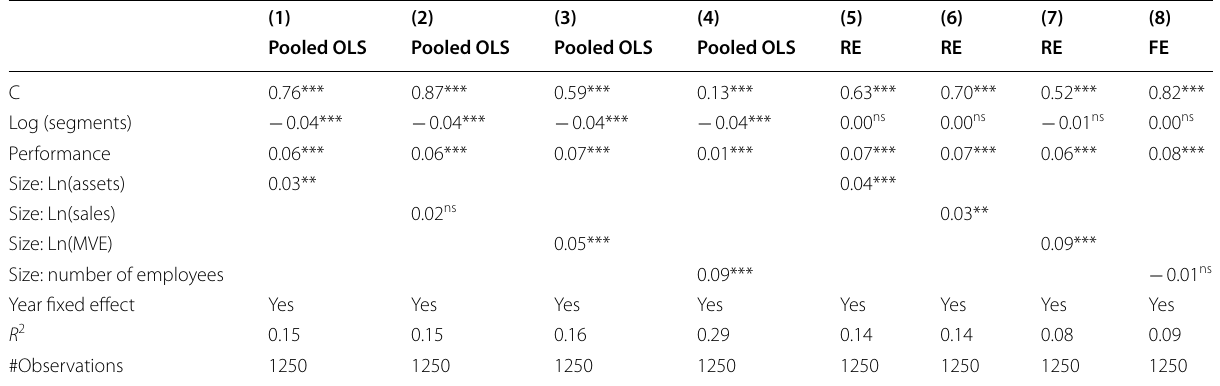
Table 10 Regression analysis of firm size (total asset, total sales, MVE and number of employees) and independent